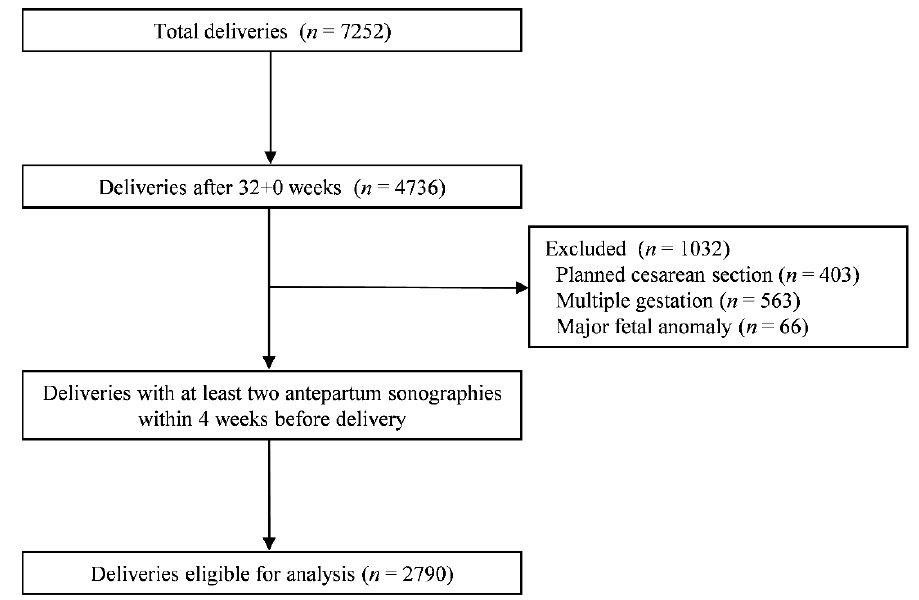
Figure 1. Flowchart of the study population.